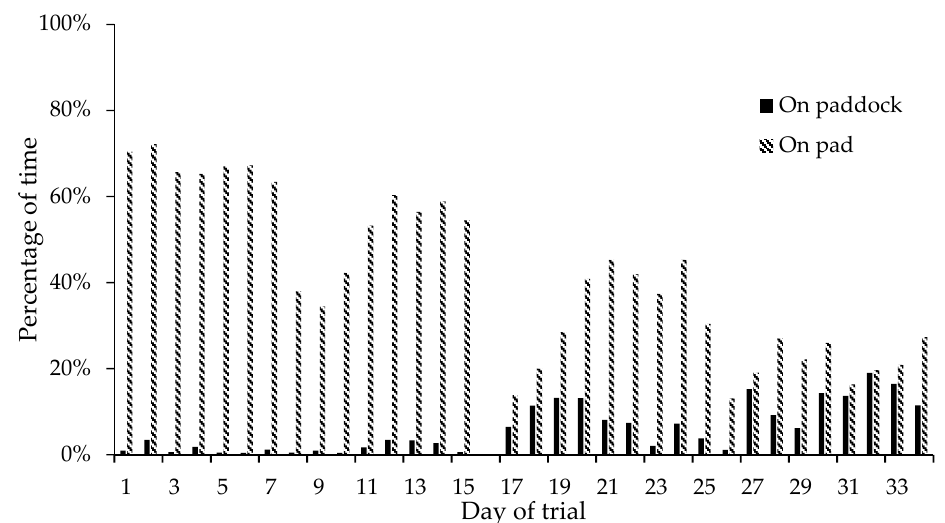
Figure 3. Mean percentage of time spent lying when on the pad or paddock for NFP Group 2. (Data logger change over (day 16) was excluded from the data).